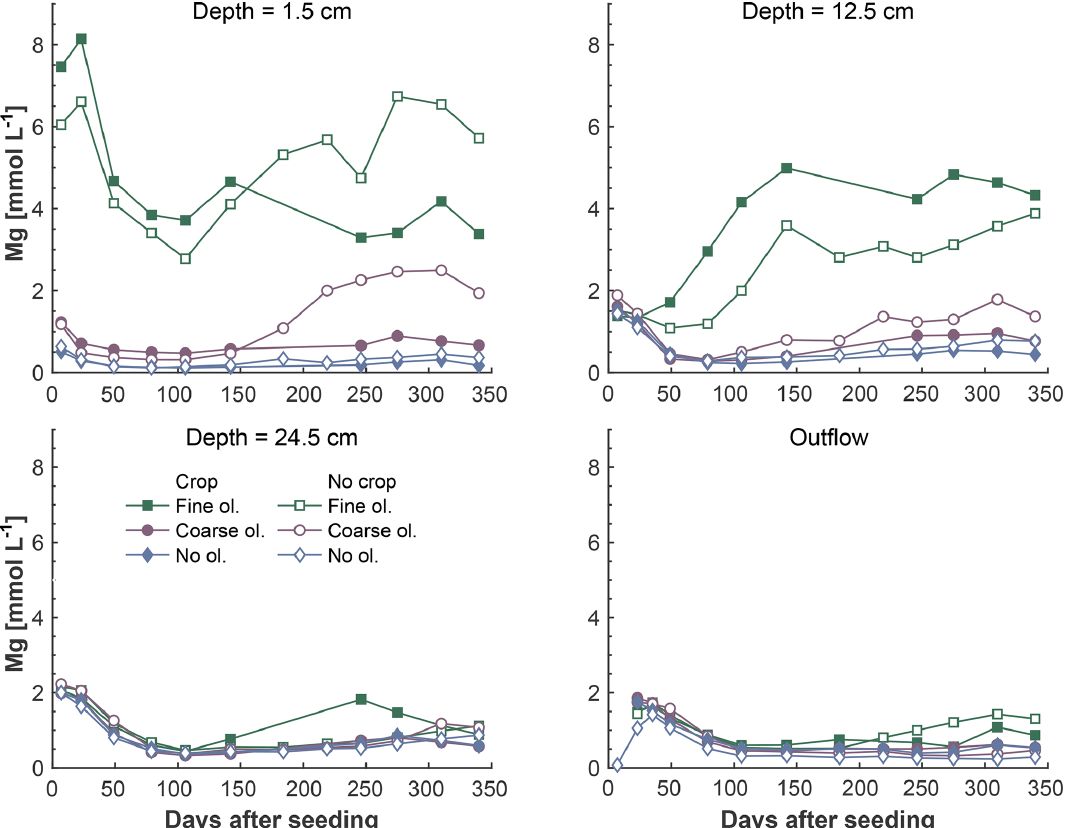
Figure 5. Development of Mg concentrations over the experiment period, differentiated by olivine and crop treatment. Data points are averages but error indicators were omitted to provide a better overview. For a more differentiated view and standard deviations, please refer to Fig.